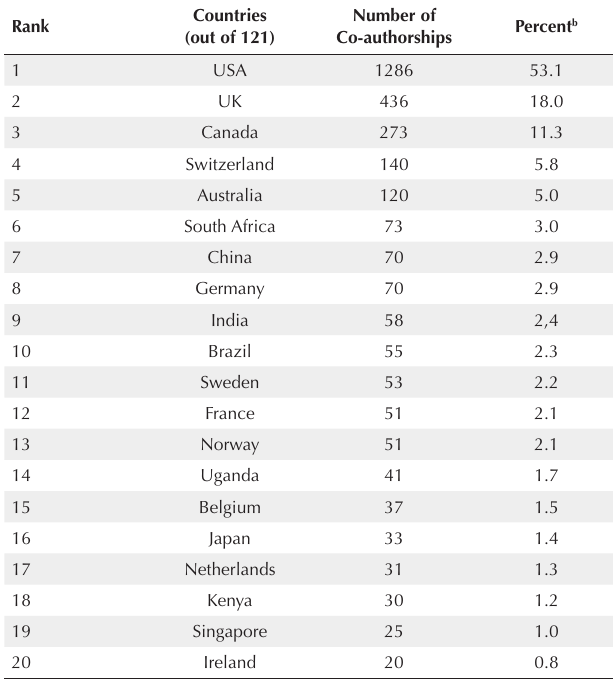
Table 1. Number of Co-authorships by Country